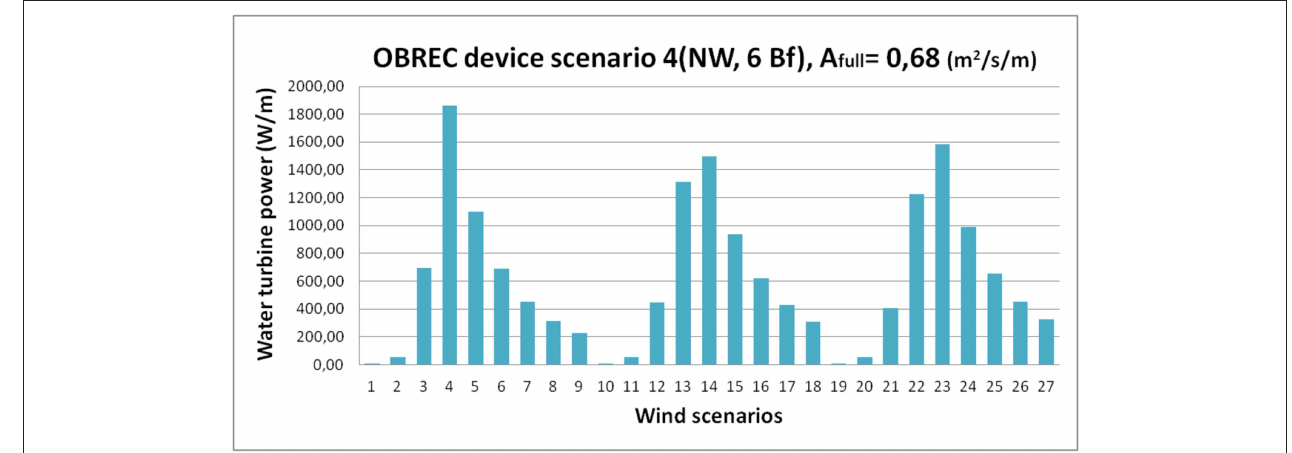
FIGURE 4 | Analysis results of the indicative OBREC device scenario 4.